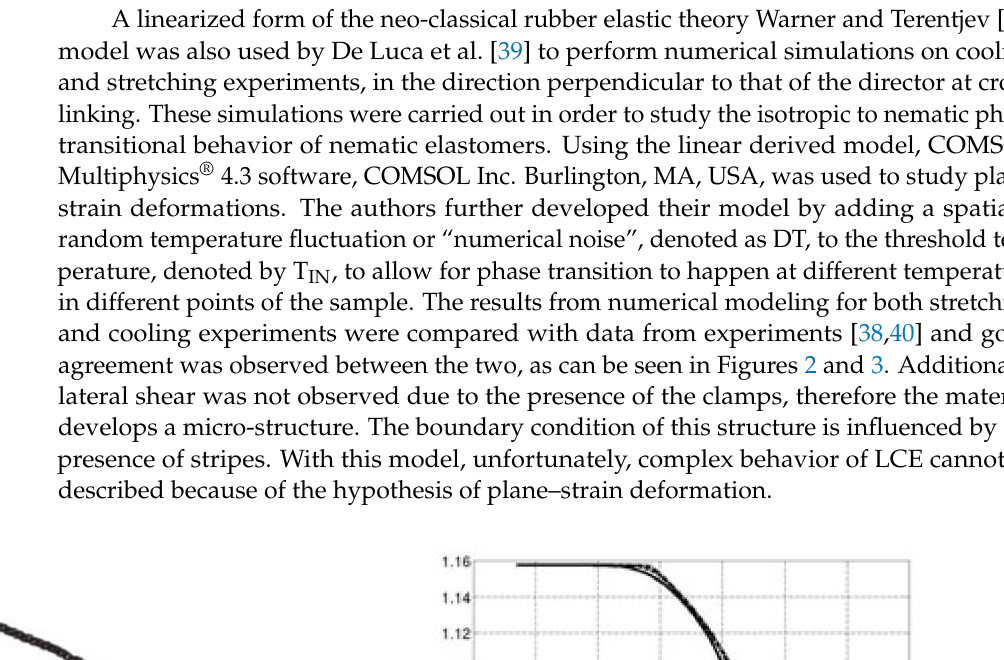
( b ) Figure 3. ( a , b ) Compare experimental data numerical results, obtained from a stretching experiment, are shown in ( a , b ), respectively [39]. The stretching direction was horizontal (Reprinted with permission from [39]). A FEM model was built by [41], using ANSYS ® software, Canonsburg, PA, USA, to bridge the gap between elastomer physics and device engineering and design. An empir- ical model was developed by the authors, for describing the material deformation, using experimental actuation data. The basic concept of the model is as follows: the absorption properties of carbon nano-tubes (CNTs) causes the irradiated light on the sample to be absorbed and consequently, turned into heat. Thus, the CNTs act as internal heat genera- tors. Finally, the opto-mechanical behavior, i.e., the mechanical deformation induced by light as stimuli, of an LCE-CNT system was evaluated and the mechanical response of the said system was optimized. The LCE-CNT system structure which was modeled was an LCE-CNT film in the shape of a cantilever structure with 1 mm length, 0.6 mm-wide, and with a thickness of 0.4 mm. Both 2D and 3D geometries were studied. Effective physical properties were considered for the entire specimen under investigation. Results showed that preliminary results obtained from simulations, using the authors’ proposed model, were in agreement with the experimental data [42]. Another advantage of the developed numerical model was that it could provide the researchers with data that was unattainable via experiment such as, the temperature distribution inside the specimens and also pre- dicting the temperature evolution for any given point in the model geometry.